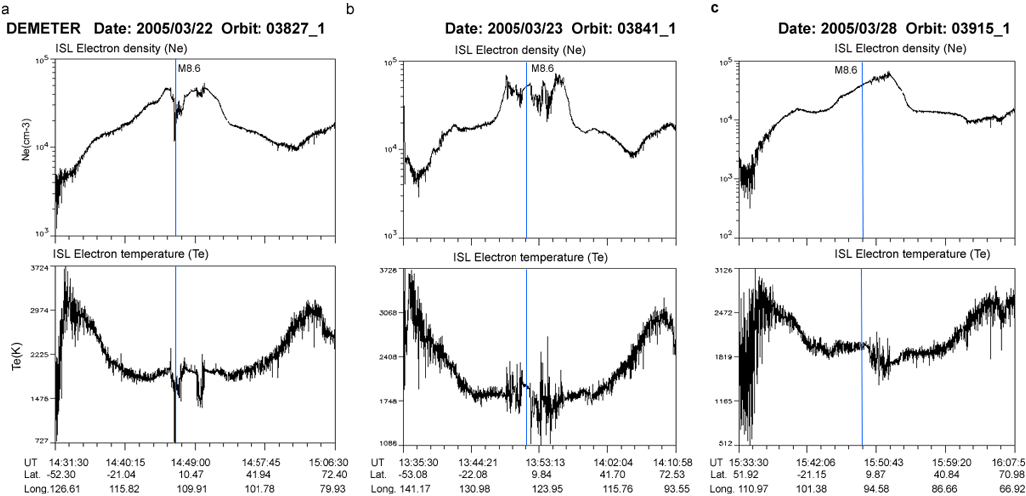
Fig. 7. The plasma depletions observed in the DEMETER electron density and temperature measurements near the epicenter by satellite orbits (a) 03827 1 on 22 March 2005, (b) 03841 1 on 23 March 2005 and (c) 03915 1 on 28 March 2005. The vertical line shows the latitude of the earthquake epicenter.